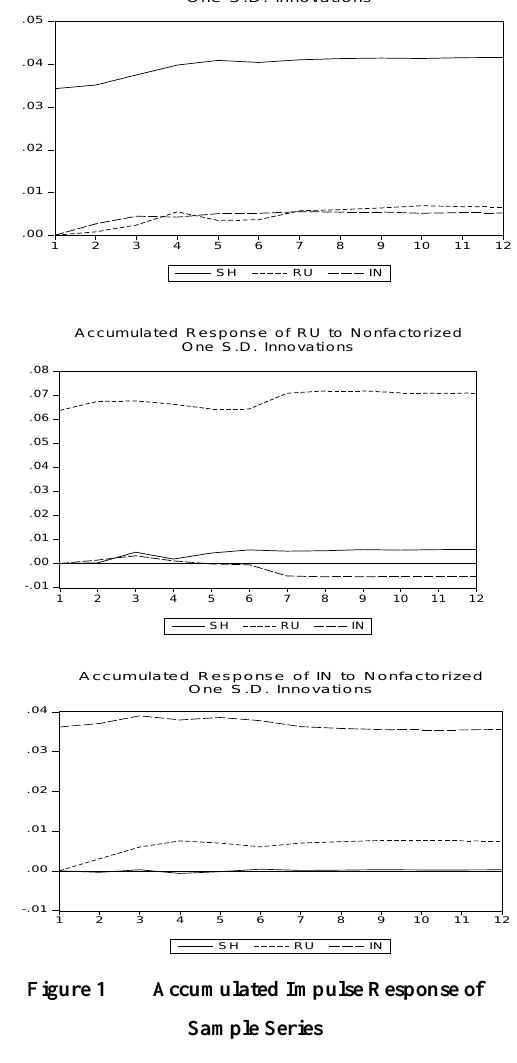
Figure 1 Accumulated Impulse Response of Sample